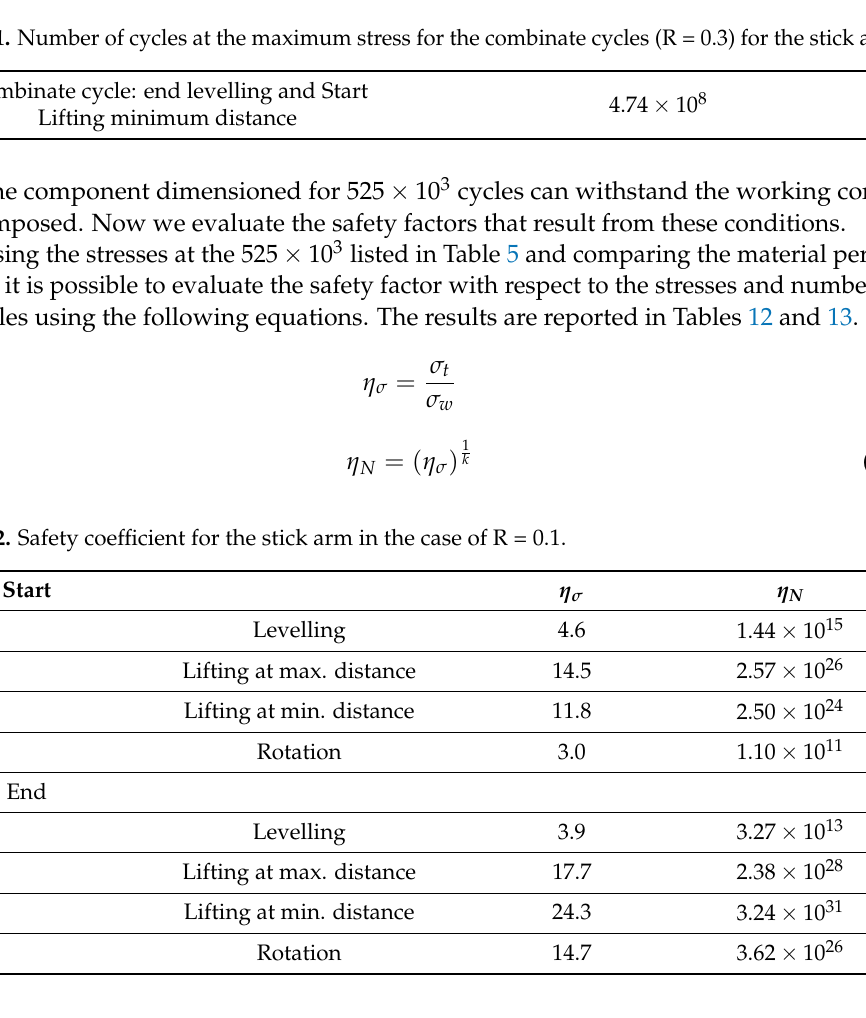
Table 13. Safety coefficient for the stick arm in case of the combinate cycle (R = 0.3). Combinate cycle: End Levelling and Start